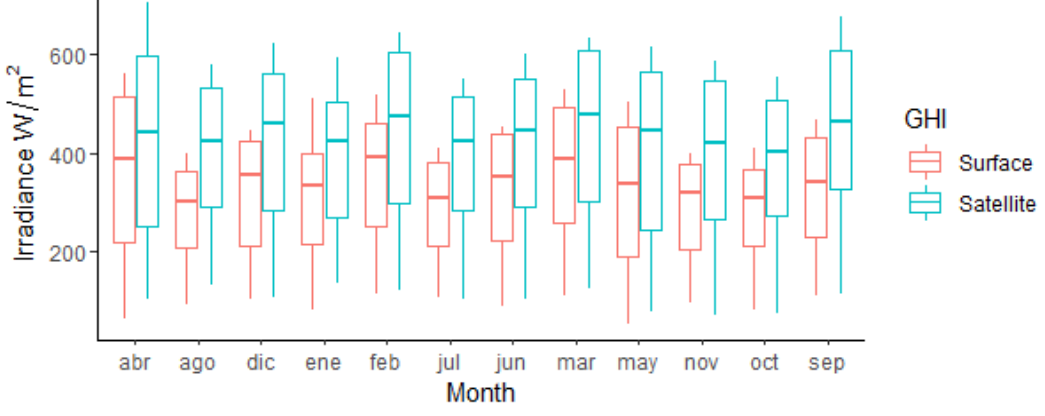
Figure 10. Comparison boxplot between surface and satellite GHI estimations, monthly profile.